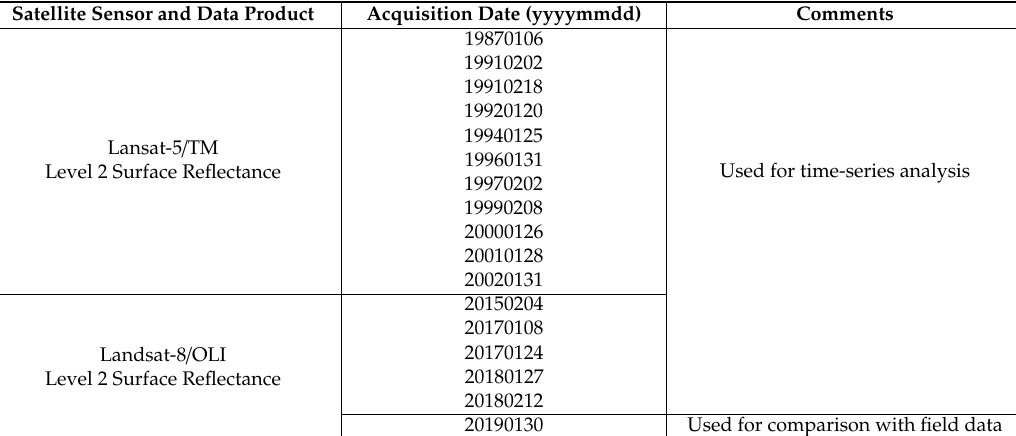
Table 2. List of satellite data used in this study.